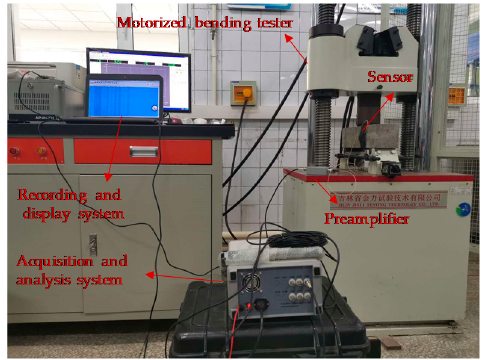
Figure 2. The specific experimental device.